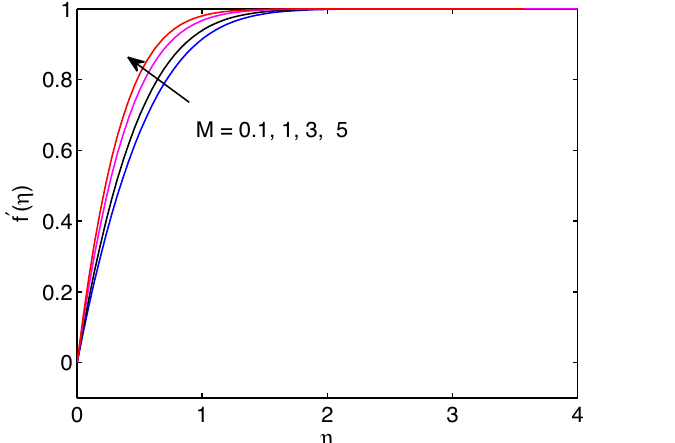
Figure 10. Magnetic field effects on velocity profiles.